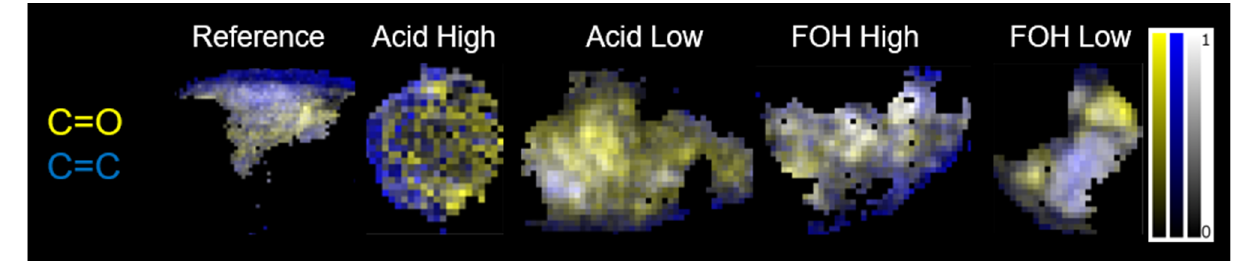
Figure 3. False color images at zero angle projection of the five formulations obtained by integrating vector normalized spectra for the ROI_1 (yellow) and ROI_2 (blue) upon 0–1 normalization of each channel. Black to white grayscale indicates the sum of the two channels.